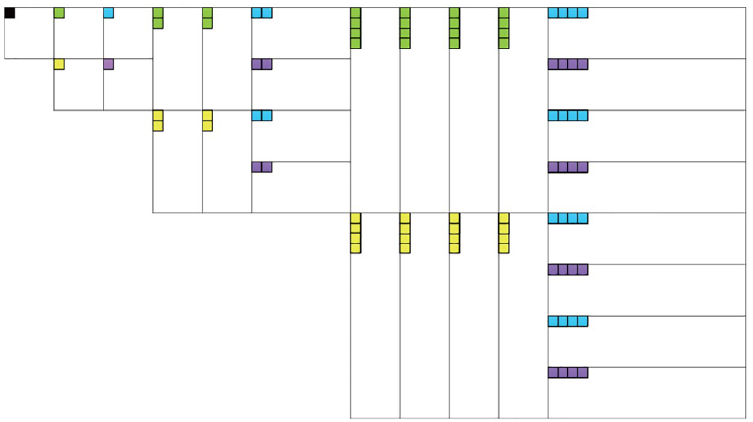
Fig 7. Related coefficients distribution in a contourlet. The coefficient colored black is the root of the other colored ones; coefficients of same colors are in the same direction.